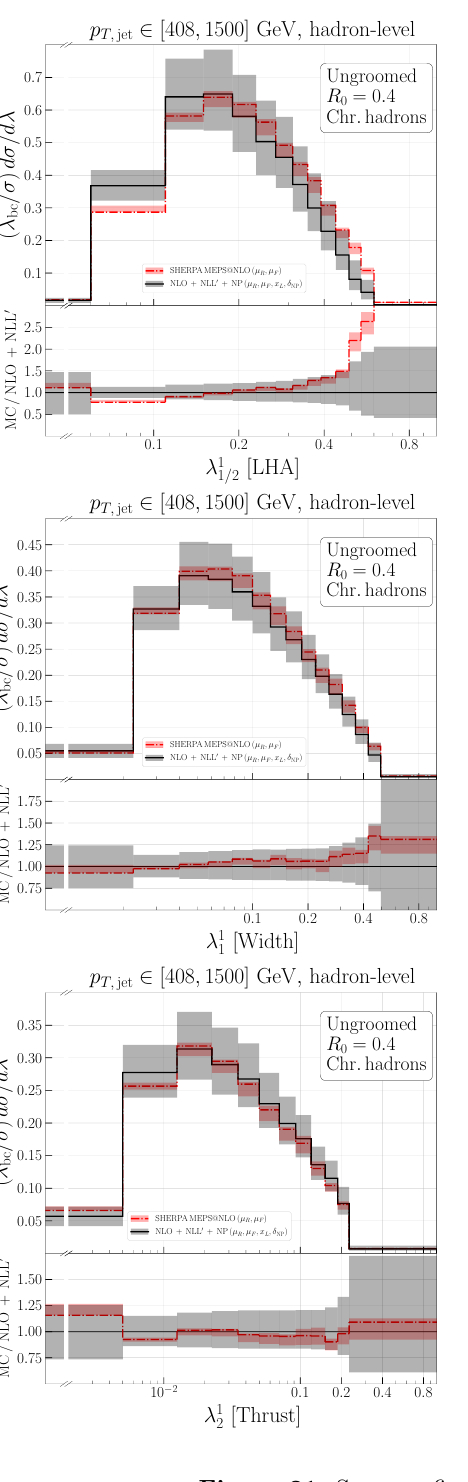
Figure 21 . Same as figure 17 but for R 0 = 0 . 4